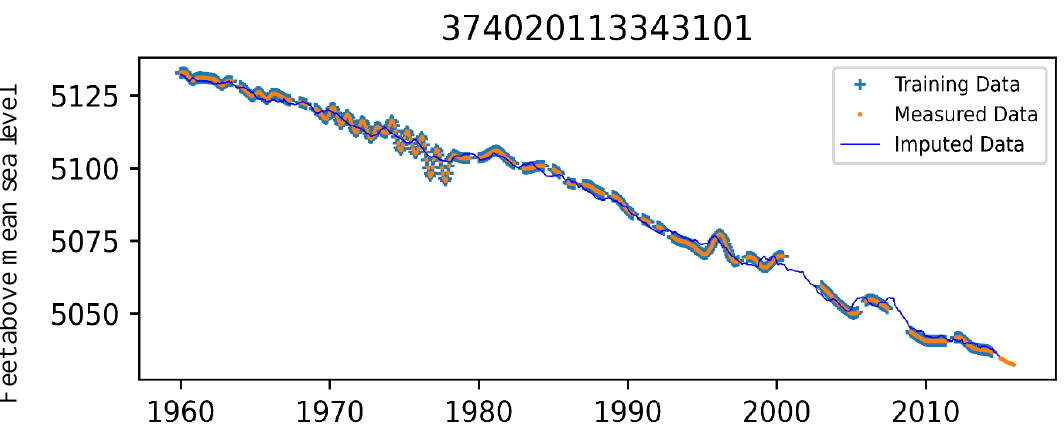
Figure 5. Example data showing measured data (orange dots), training data (blue crosses), and imputed data (blue lines) over the entire period. All measured data were used to train the model used to impute data for the gaps. This figure includes imputed data over the entire period to show how the ELM optimal fit minimizes the error but does not exactly match the measured data.